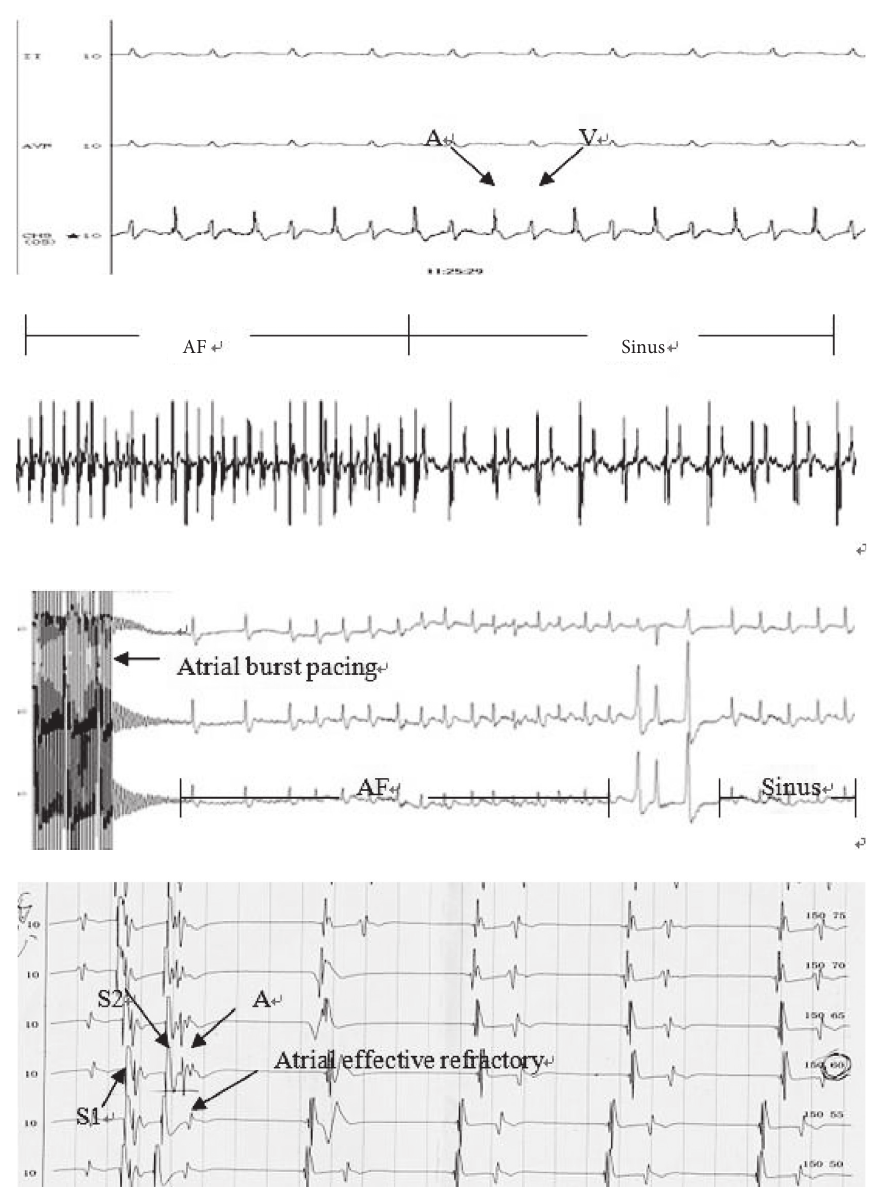
Figure 5: (a) Electrophysiological examination: the optimal position of atrial wave amplitude higher than ventricular wave amplitude. (b) AF turns into sinus rhythm. (c) Atrial Burst stimulation (S1S1 20ms): continuous stimulation for 30s was used to induce AF, which was repeated 3 times. The disappearance of the P-wave and the occurrence of a typical F-wave were the markers of AF. (d) Atrial effective refractory period (AERP): AERP is defined as the longest s1-S2 interval without atrial